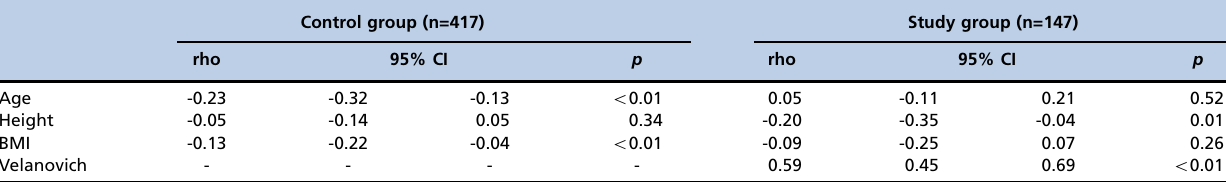
Table 3 - Correlation of age, height, body mass index, and Velanovich score with EAT-10 scores (Spearman ’ s correlation coefficient [rho]). Control group